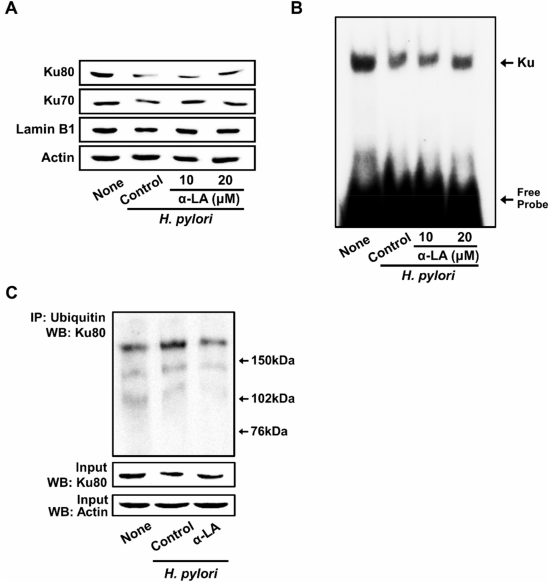
Figure 4. α -LA inhibits H. pylori -induced decreases in the nuclear Ku70/80, Ku–DNA binding activity, and ubiquitination of Ku80 in AGS cells. The cells were incubated with α -LA at the indicated concentrations for 2 h, then stimulated with an H. pylori to AGS cells ratio of 100:1 for 24 h. ( A) Western blots of Ku70/80 in nuclear extracts. Actin and lamin B1 served as the loading control and nuclear marker, respectively. ( B ) The activity of Ku binding to DNA in the nuclear extracts was determined by an electrophoretic mobility shift assay. ( C ) Whole-cell extracts were immunoprecipitated (IP) with the anti-ubiquitin antibody, followed by Western blot analysis (WB) with anti-Ku80 antibody. The levels of the input proteins, Ku80 and actin, were determined by Western blot analysis. Input was used as the control for the protein expression.